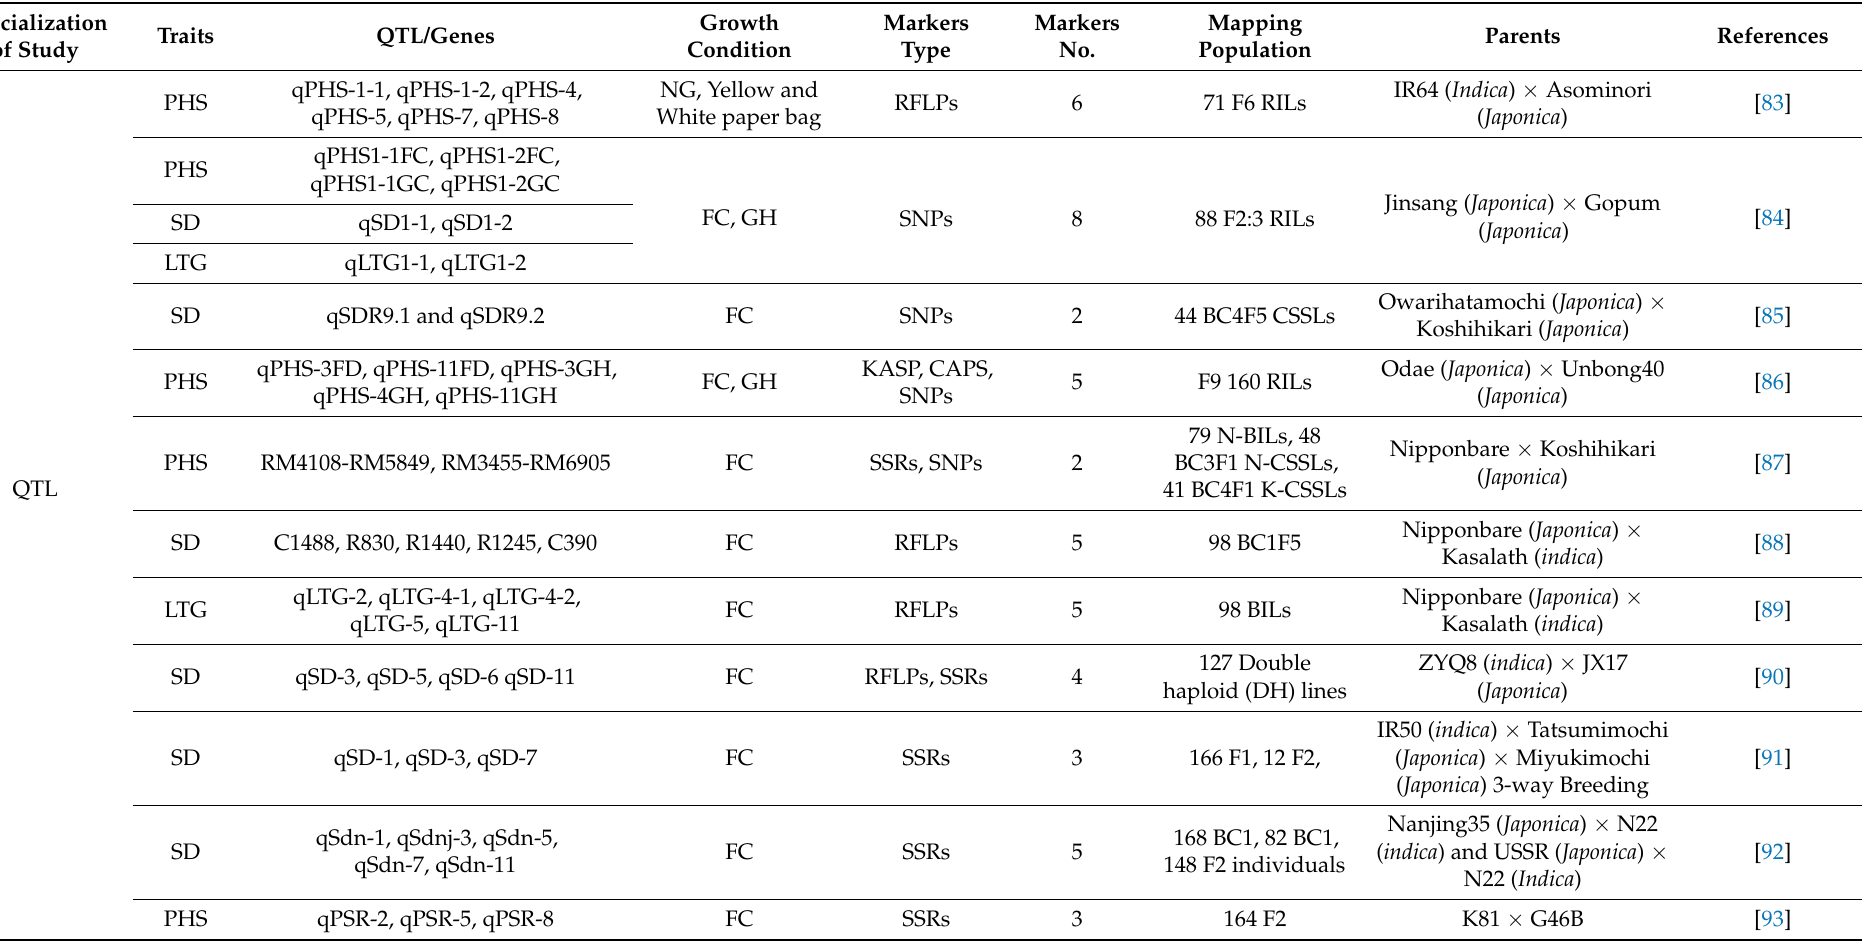
Table 1. Summary of quantitative trait loci and genome-wide association studies for pre-harvest sprouting-related traits identified in